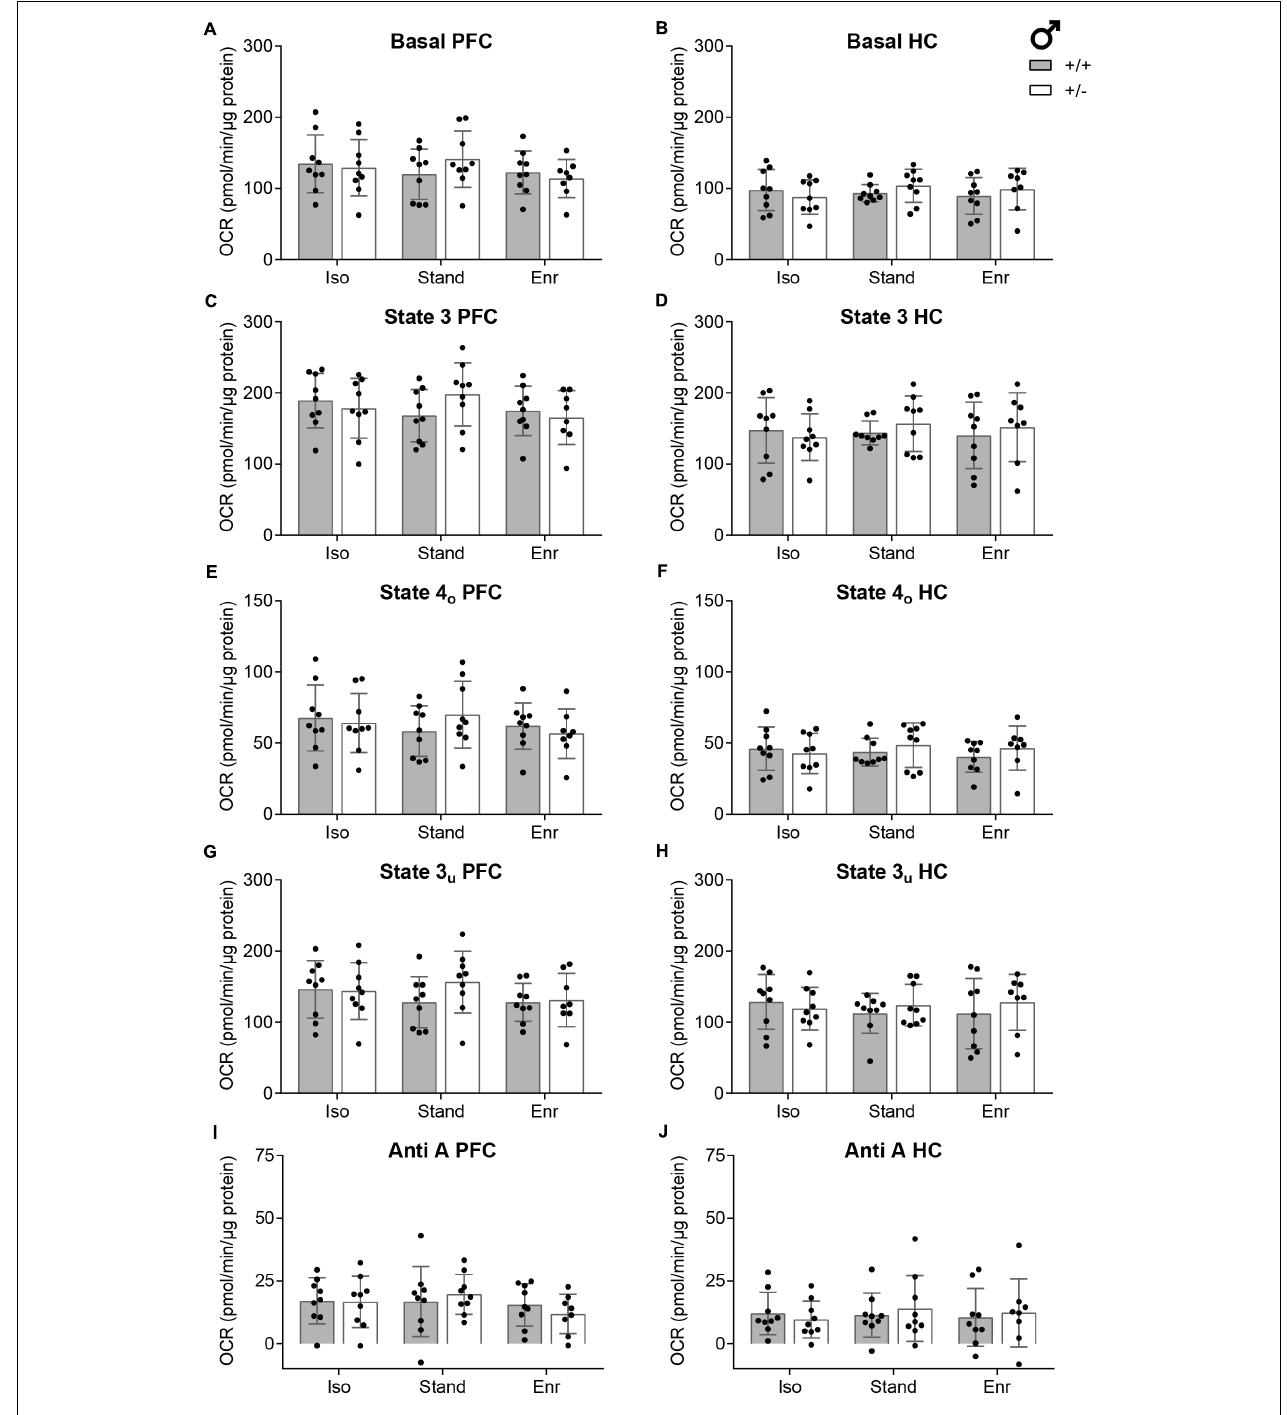
FIGURE 4 | Indices of mitochondrial function calculated from the OCR measurements. Individual parameters of the bioenergetics measurements with isolated mitochondria from rat right prefrontal cortex (PFC; A,C,E,G,I ) and right hippocampus (HC; B,D,F,H,J ) are specified. (A,B) With rotenone and succinate present in the assay buffer, the Basal rate implies the ADP-independent, complex II-mediated respiration. (C,D) The State 3 OCR is initiated with the injection of ADP and accounts for the phosphorylating respiration. (E,F) State 4 o is induced by the addition of the ATP synthase inhibitor oligomycin and stands for the non-phosphorylating respiration. (G,H) FCCP uncouples the oxygen consumption from ATP production and is used to assess State 3 u , which represents the maximal respiratory activity. (I,J) The Anti A rate constitutes the OCR response to antimycin A which inhibits the mitochondrial respiration. The parameter values are calculated as absolute oxygen consumption rate in pmolO 2 /min/6 µ g mitochondrial protein. The data of n = 8–9 2-month-old male rats per group are presented as mean ± SD. OCR, oxygen consumption rate; + / + , wildtype Cacna1c + / + (gray bars); + / − , heterozygous Cacna1c + / − (clear bars); Iso, isolation; Stand, standard housing; Enr,